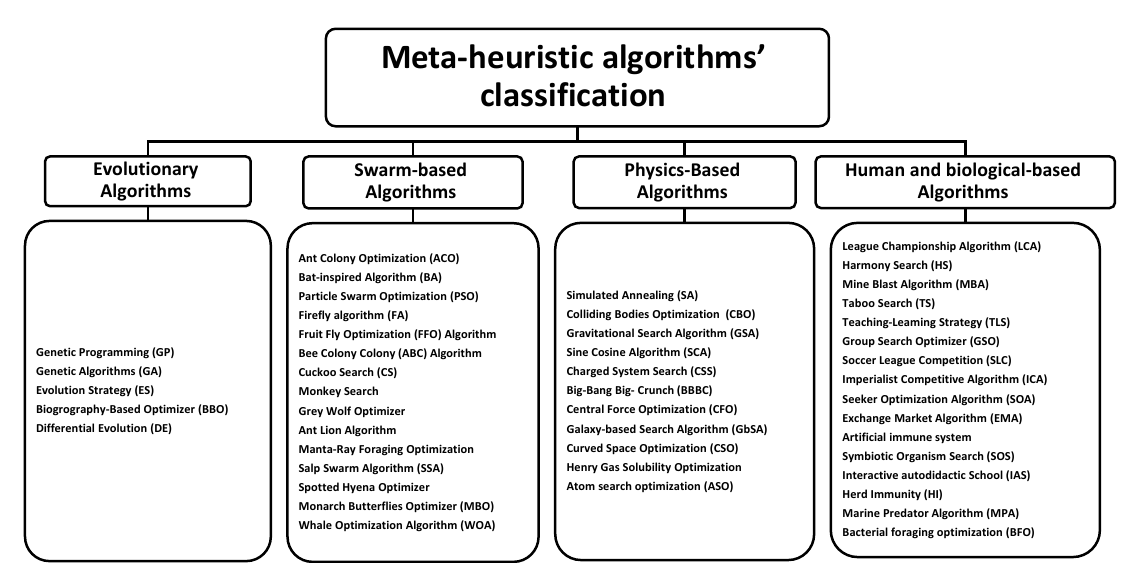
Figure 1. Meta-heuristic algorithms’ classification.